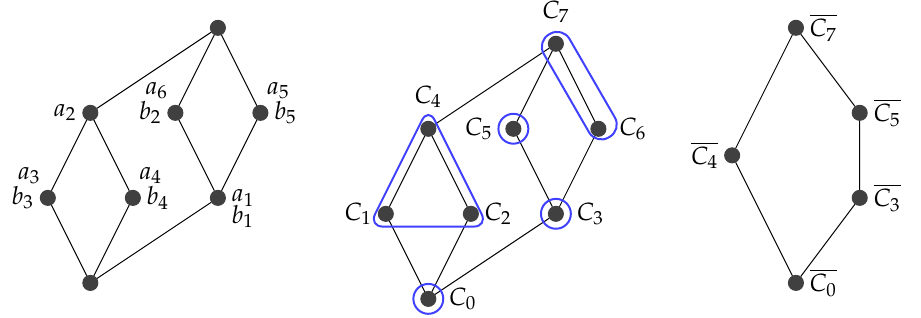
Figure 3. Concept lattices of Example